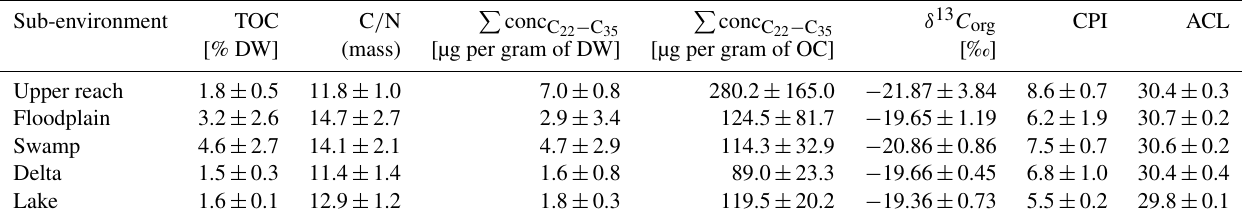
Table 1. Chemical parameters of sedimentary bulk organic matter: total organic carbon content (TOC) in % dry weight (DW), carbon- to-nitrogen ratio (C / N), summed concentration of medium to very long-chain plant-wax-derived n -alkanes normalized to dry weight, and organic carbon (OC), and bulk organic carbon isotopic composition in per mil in reference to Vienna Pee Dee Belemnite.